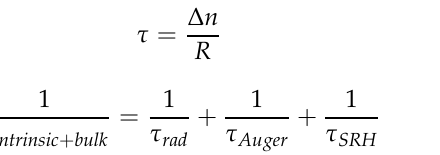
Figure 7. Fitting results of injection dependent-carrier lifetime for the PERC A and B.